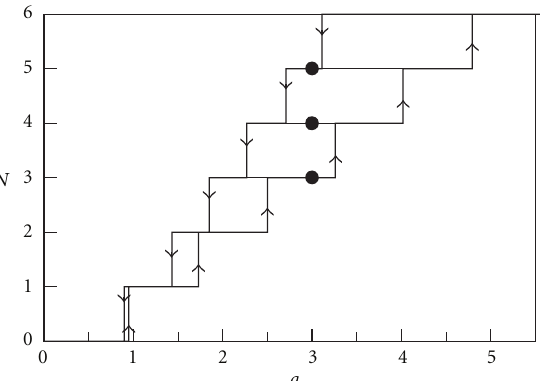
Figure 5: Dependence of the peak intensity I 0 of intracavity identical pulses in established operation on pumping a .